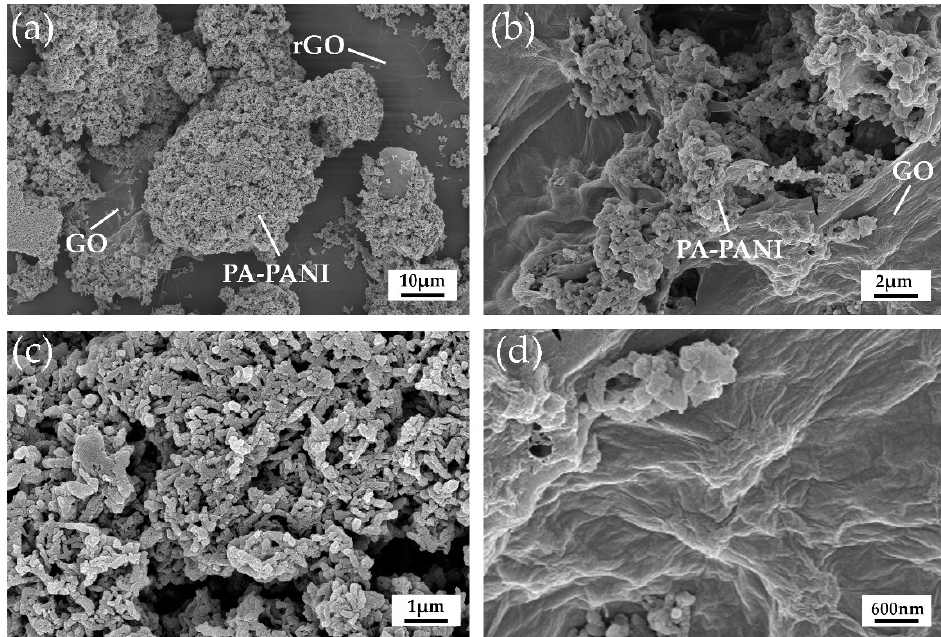
Figure 3. Characterization of materials by scanning electron microscopy. ( a ) The FE-SEM image of GO+PA-PANI/rGO composite sensitive membrane. ( b ) The FE-SEM image of PA-PANI and GO mixture. ( c ) The FE-SEM image of PA-PANI from ( a ). ( d ) The FE-SEM image of GO from ( b